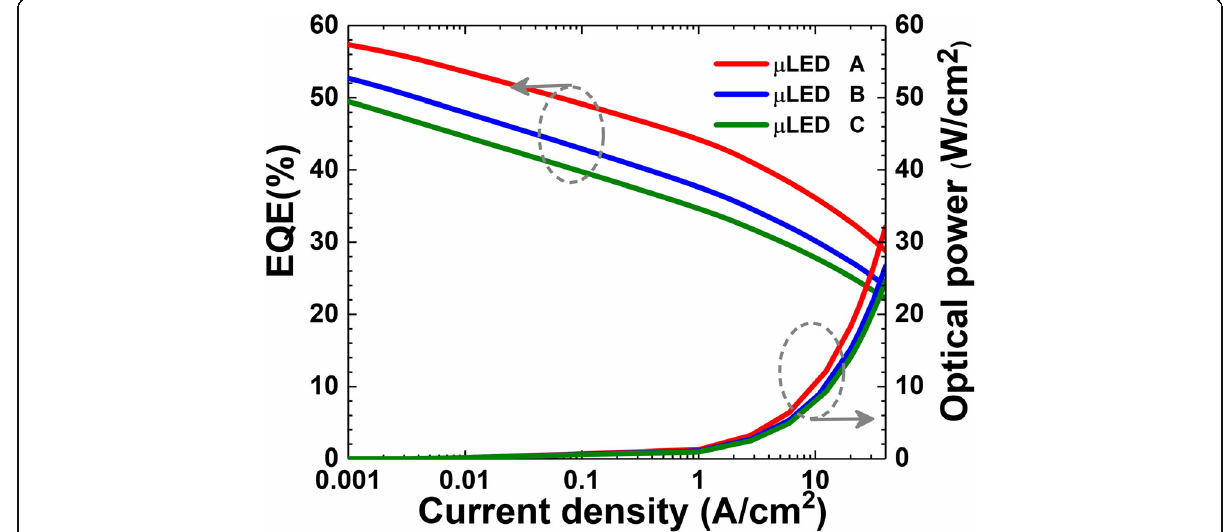
Fig. 1 Calculated EQE and optical power density in terms of the injection current density for μ LEDs A, B, and C,